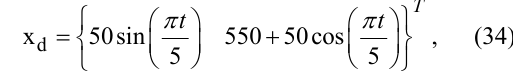
Figure 8. The angular velocity with the kinematic NMPC- PSO